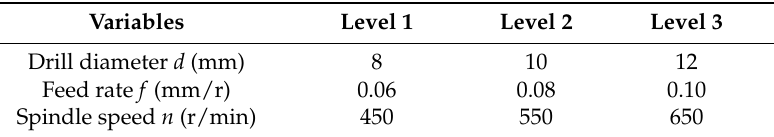
Table 1. Drilling parameters and their levels.